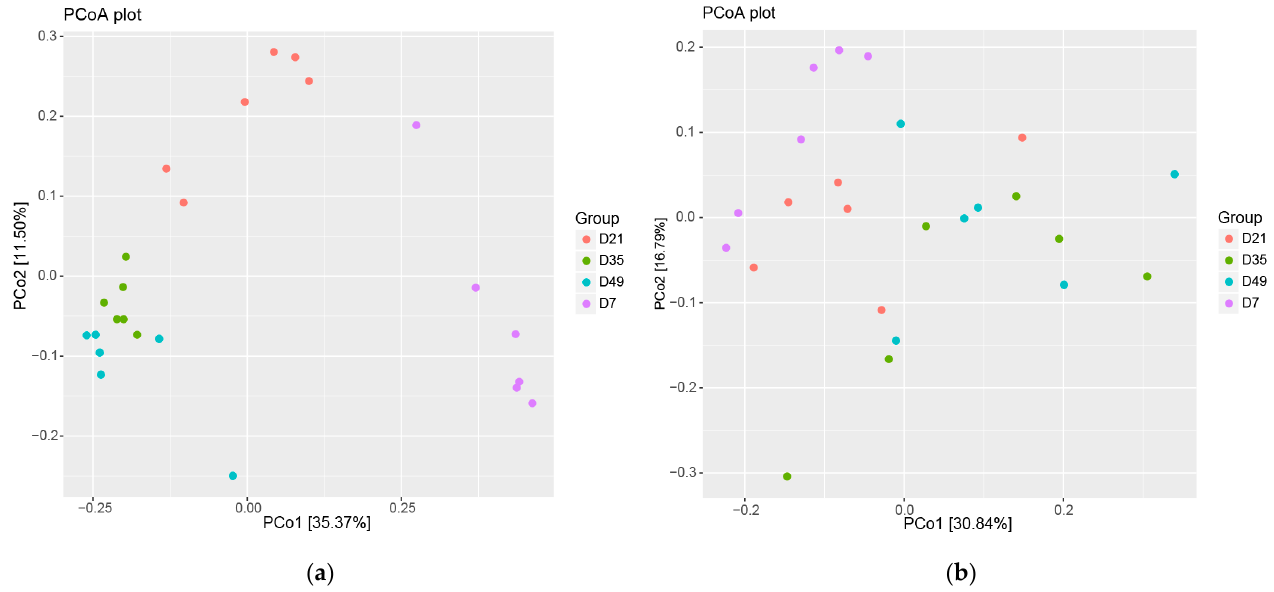
Figure 2. Development of gut microbial operational taxonomic units (OTUs) as the early lambs aged. ( a ) Unweighted UniFrac distances based on relative abundance of microbial OTUs, ( b ) Weighted UniFrac distances based on relative abundance of microbial OTUs.